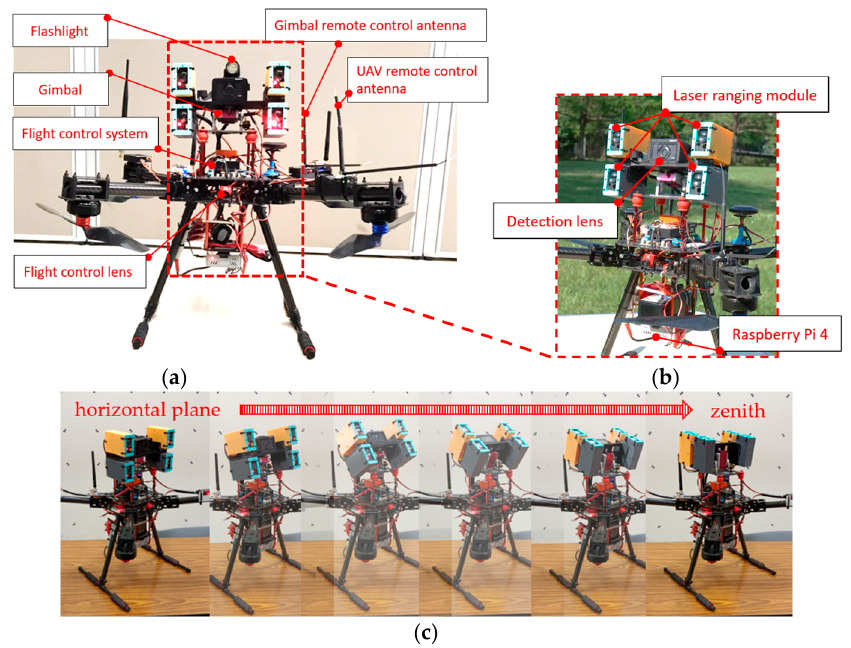
Figure 2. Self-assembled unmanned aerial vehicle (UAV) system for bridge inspection: ( a ) architec- tural diagram of the UAV; ( b ) architectural diagram of the inspection lens; ( c ) inspection camera from horizontal plane rotated to zenith.